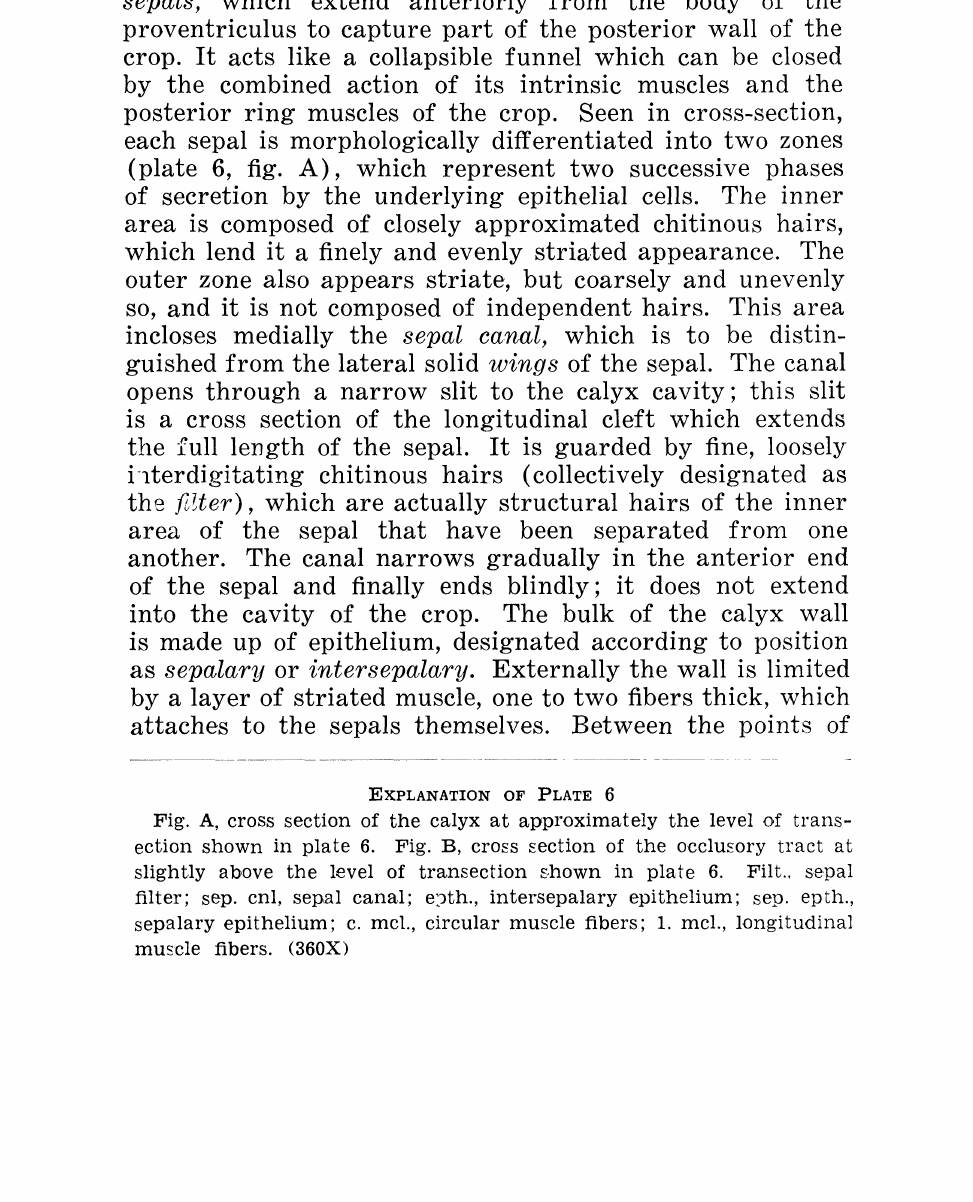
Fig. A, cross section of the calyx at approximately the level of trans- ection shown in plate 6. Fig. B, cros ection of the occluory tract at slightly above the level of transection hown in plate 6. Filt.. sepal filter; sep. cnl, sep,al canal; e’.th., intersepalary epithelium; sep. epth., sepalary epithelium; c. mcl., circular muscle fibers; 1. incl., longitudinal muscle fibers.